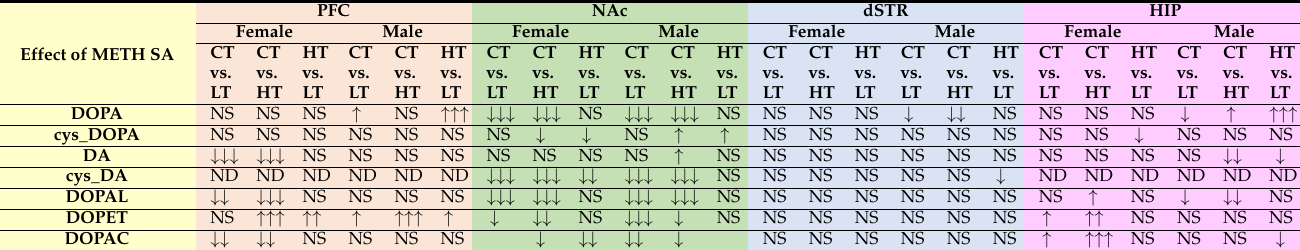
Table 2. Effects of METH SA on dopamine and its